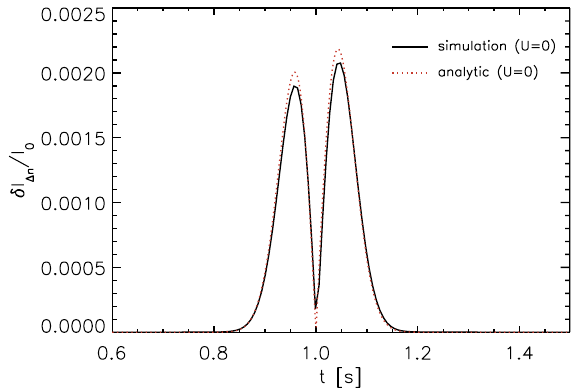
FIG. 1. (Color) Comparison of the simulation result (solid line) with the analytic result (red dotted line) for the ballistic echo amplitude ( U (cid:2) 0 ) versus time. The delay time between the two rf kicks is (cid:6) (cid:2) 0 : 1 s